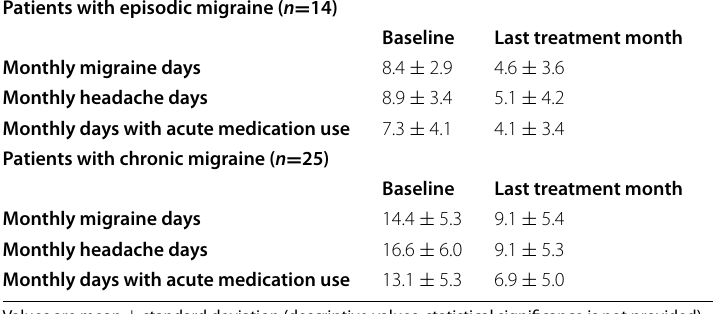
Values are mean standard deviation (descriptive values, statistical significance is not provided) ±